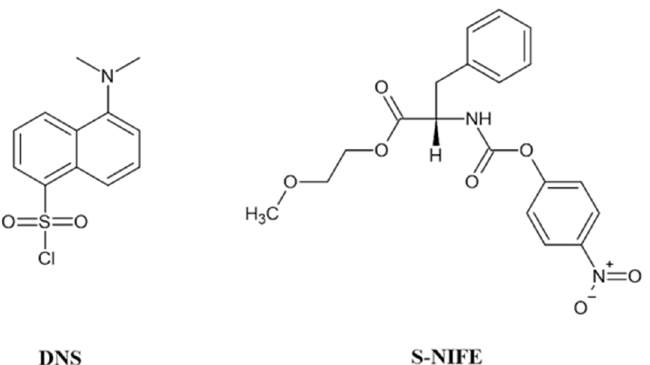
Figure 8. Chemical structure of 5-(dimethylamino)naphthalene-1-sulfonyl chloride (DNS) and N -(4-nitrophenoxycarbonyl)-L-phenylalanine-2-methoxyethylester (S-NIFE).